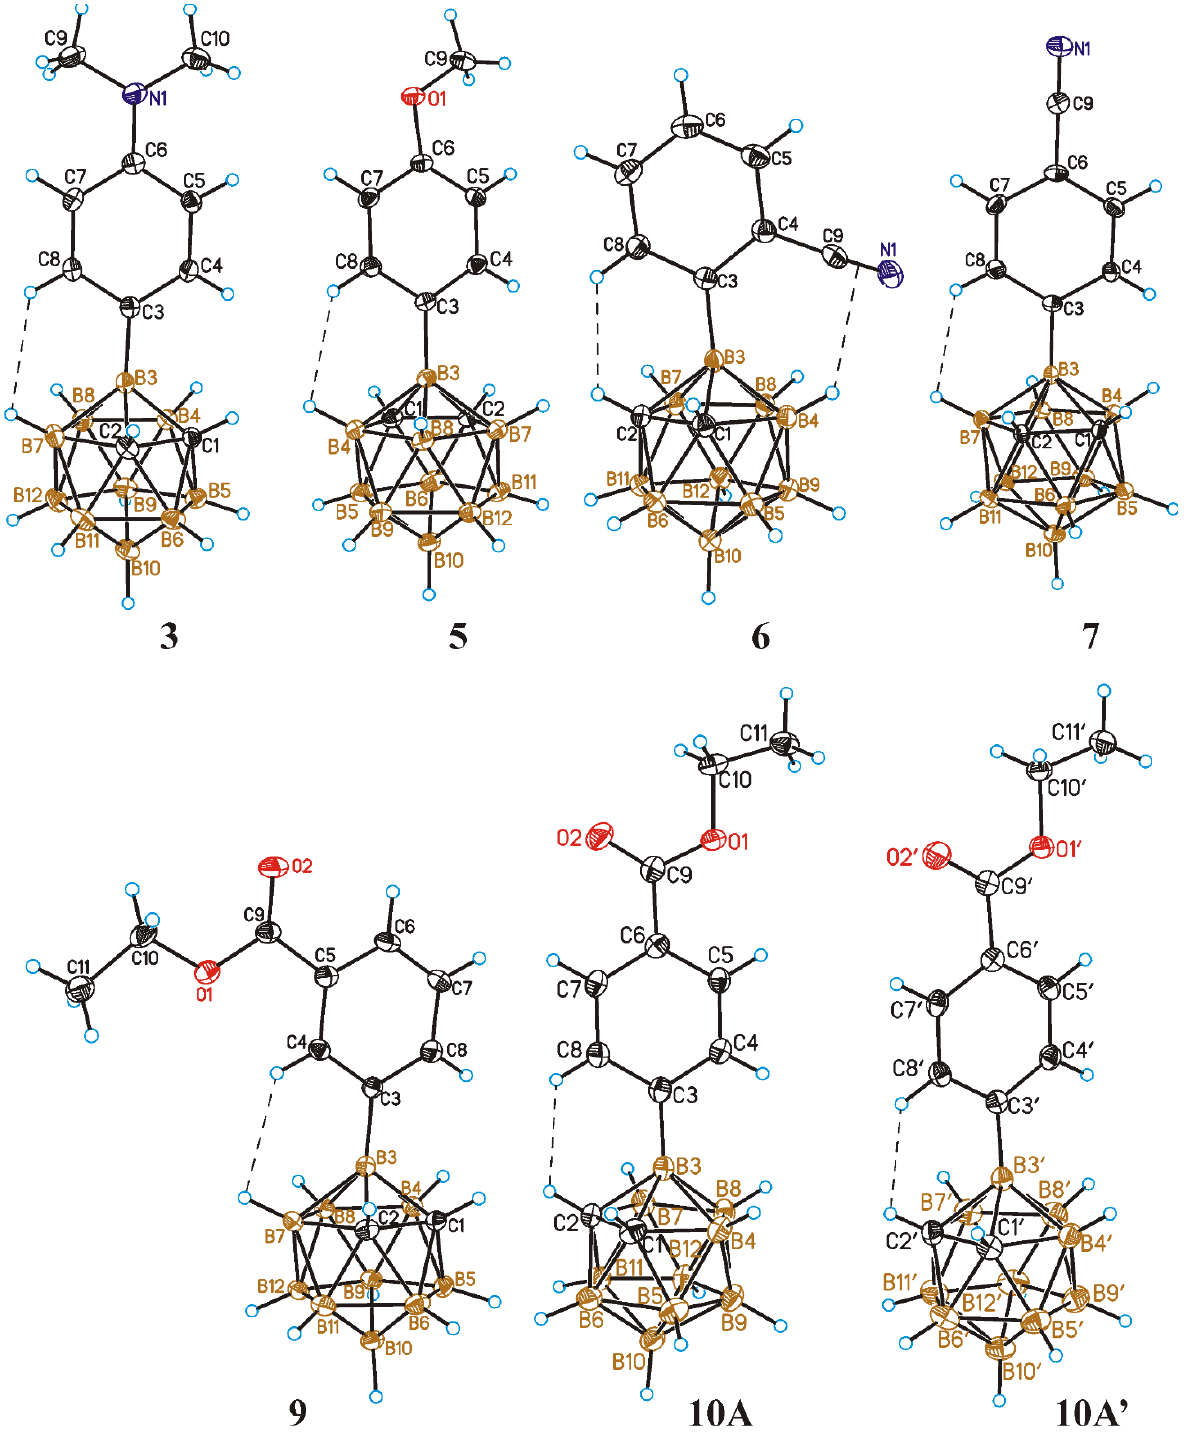
Figure 1. General views of 3-( p -Me 2 NC 6 H 4 )-1,2-C 2 B 10 H 11 ( 3 ), 3-( p -MeOC 6 H 4 )-1,2-C 2 B 10 H 11 ( 5 ), 3-( o -NCC 6 H 4 )-1,2-C 2 B 10 H 11 ( 6 ), 3-( p -NCC 6 H 4 )-1,2-C 2 B 10 H 11 ( 7 ), 3-( m -EtOOCC 6 H 4 )-1,2-C 2 B 10 H 11 ( 9 ), and 3-( p -EtOOCC 6 H 4 )-1,2-C 2 B 10 H 11 ( 10 ) (both symmetri- cally independent molecules are presented) showing atomic numbering. Thermal ellipsoids are drawn at 50% probability level. For each structure, the shortest H···H and H··· π contacts are shown by dashed lines. The H…H distances are equal to 2.43, 2.43, 2.18, 2.44, 2.47, 2.27, and 2.37 Å for compounds 3 , 5 , 6 , 7 , 9 , 10 A, and 10 A ′ , respectively. The distance of the H··· π contact for 6 (from H atom δ to the center of the C ≡ N bond) is equal to 2.80(2) Å.